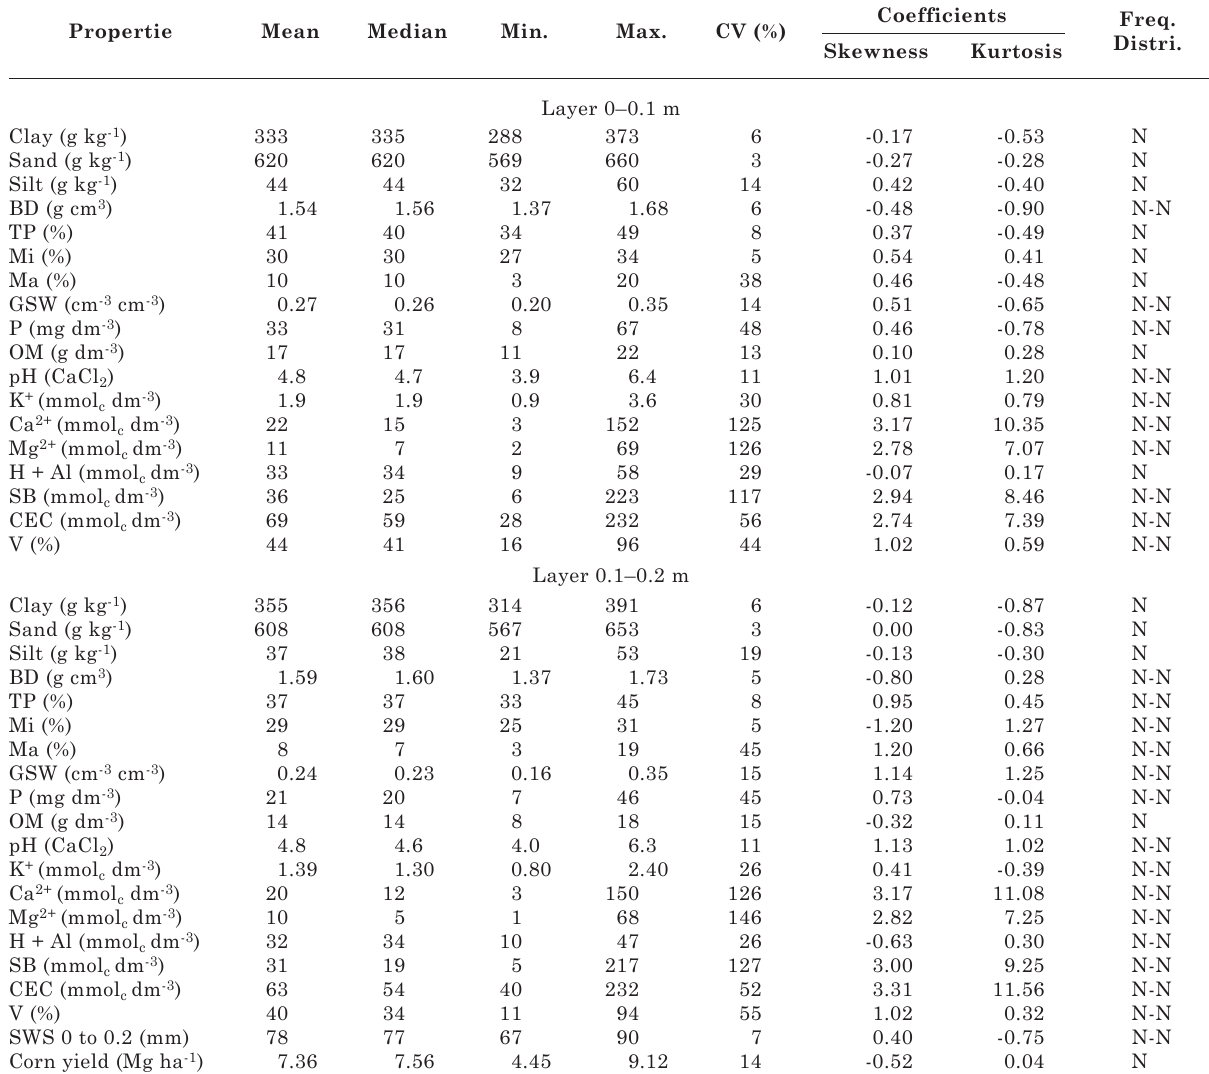
table 1. descriptive statistics for soil properties of the 0–0.1 and 0.1–0.2 m layers and for corn yield